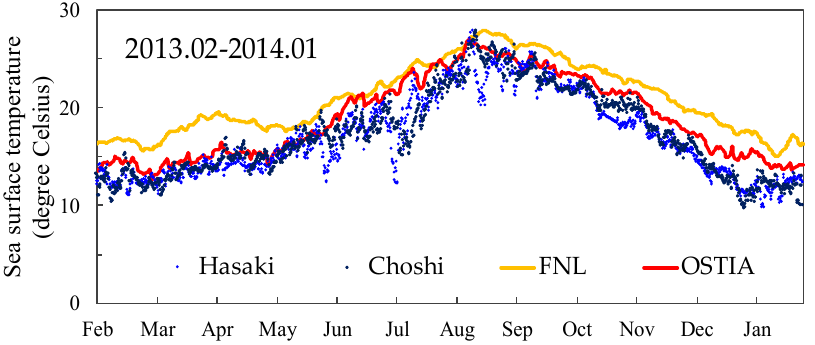
Figure 11. Time series of sea surface temperature by FNL, OSTIA, and observations at Choshi and Hasaki.